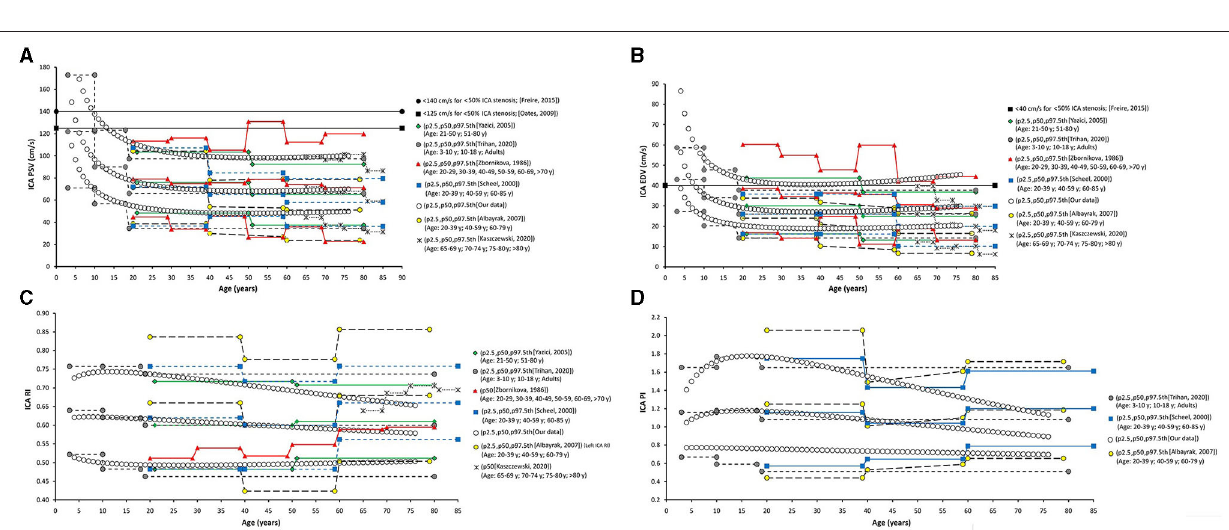
FIGURE 7 | Common carotid artery. Comparison among curves of PSV (A) , EDV (B) , RI (C) , and PI (D) , obtained in our study (2.5th, 50th, and p97.5th percentiles) and mean values (p50th), and 2.5th (MV-1.96 × SD) and 97.5 (MV + 1.96 × SD) percentiles obtained by other authors when studying groups of subjects of different ages. The fixed cut-off levels used to identify (graduate) levels of arterial stenosis are also shown.